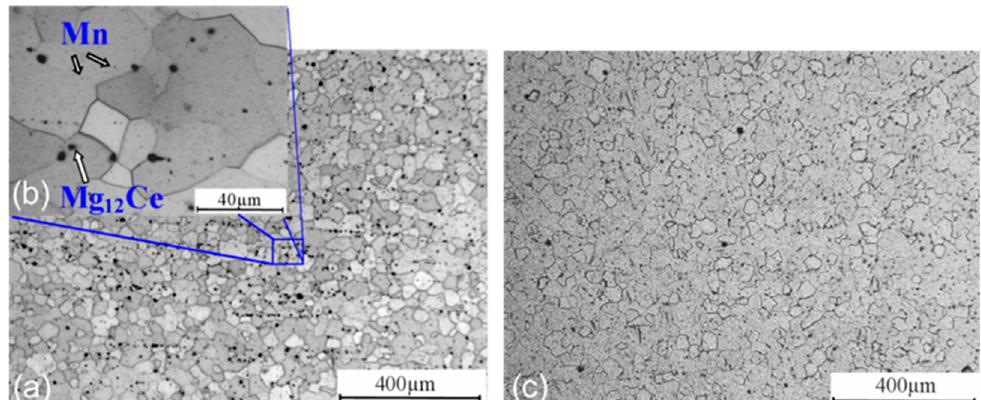
Figure 1. Microstructure of the heat treated ME21 material; (a,b) longitudinal section (=ED), ( a ) 50×, ( b ) 500×; ( c ) cross section, 200×.